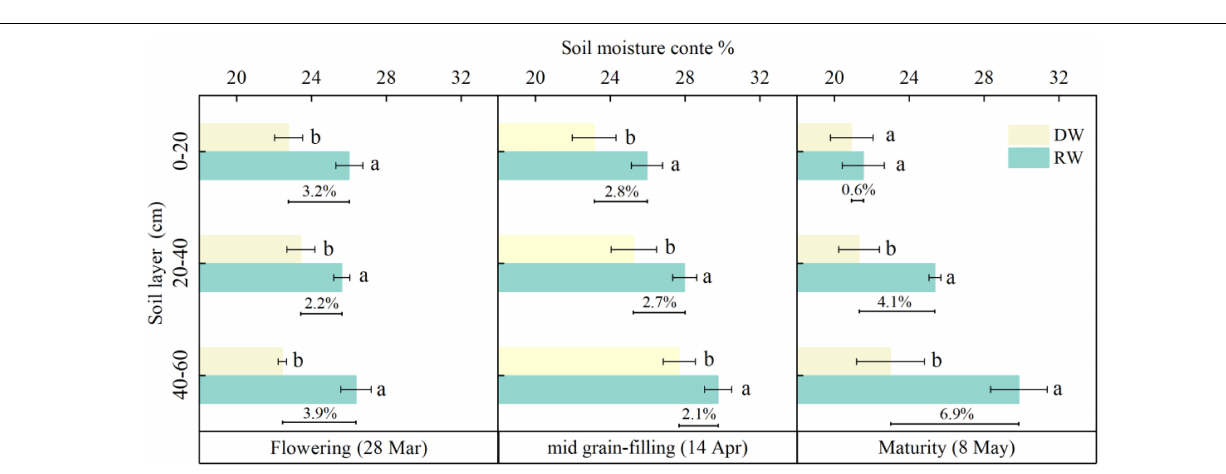
difference between nitrogen treatment (except for AE N in 2017–